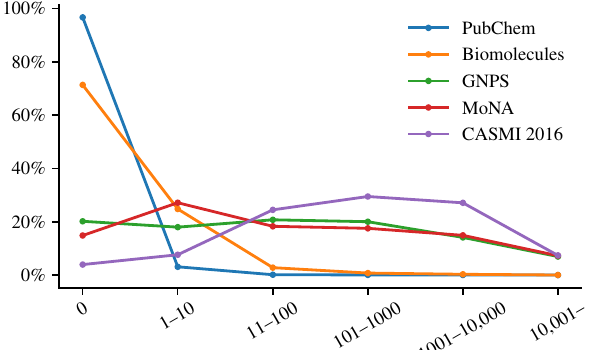
Figure 1. Citations per compound for two structure databases (PubChem, biomolecules) and three spectral libraries (GNPS, MoNA, CASMI 2016 training and testing data). The biomolecular struc- ture database is a union of several public structure database including HMDB [26], ChEBI [27], KEGG [28] and UNPD [29]. Citation counts are estimated as the number of PubMed IDs associated with the PubChem compound ID, parsed from the file “CID-PMID.gz” provided by PubChem. For the biomolecular structure database, PubChem, GNPS, and MoNA, we uniformly sub-sampled 10,000 compounds each. For every compound, we use the maximum citation count of the corre- sponding molecular structure (first InChIKey block). We excluded rare cases where the molecular structure was not found in PubChem. Dots are connected by lines solely for visualization